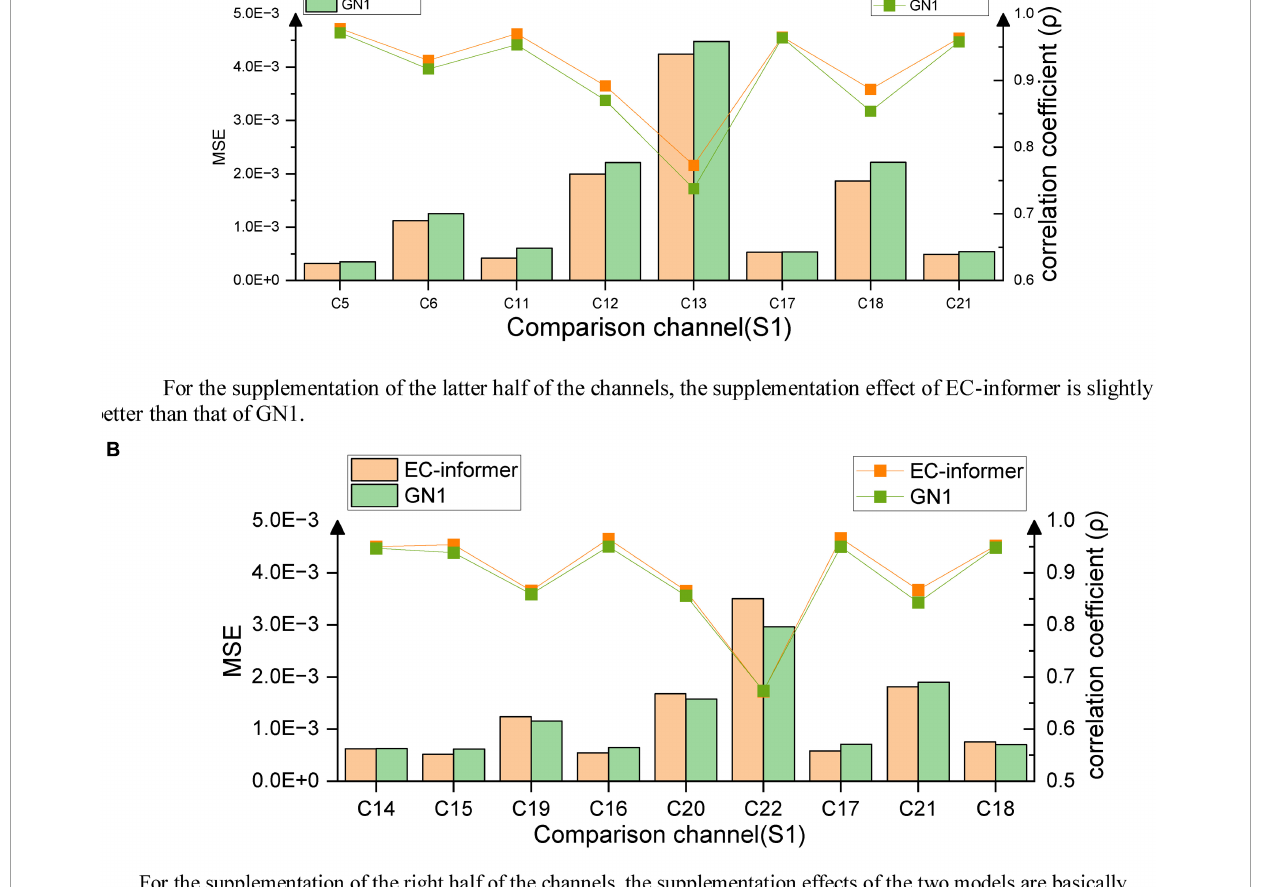
FIGURE12 Evaluation results of opposite complementary signals, (A) completion results of the right channels, (B) completion results of the left channels. (A) For the supplementation of the latter half of the channels, the supplementation effect of EC-informer is slightly better than that of GN1. (B) For the supplementation of the right half of the channels, the supplementation effects of the two models are basically the